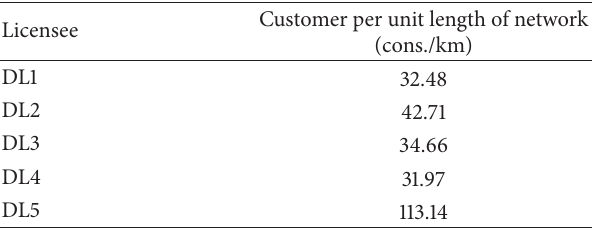
Table 6: Consumers per unit length of